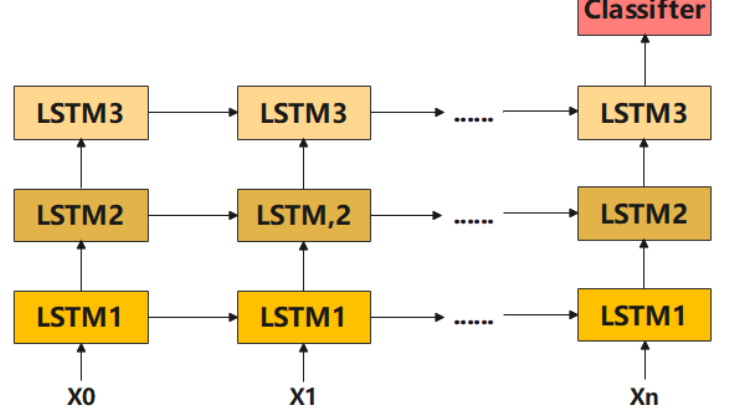
Figure 15. LSTM algorithm process model diagram.